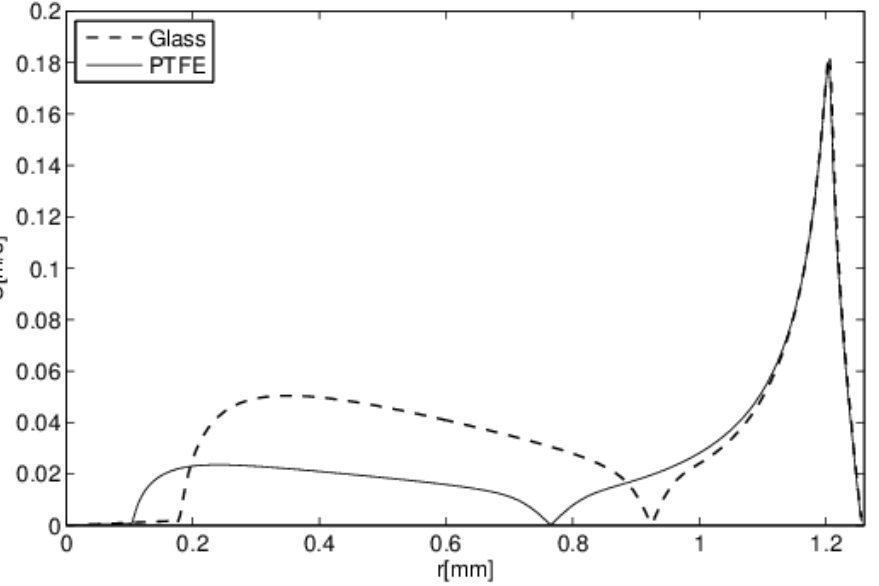
Figure 14. TBH configuration: velocity evolution along the interface. Influence of the substrate nature (t = 1 s, θ = 90 ◦ , V 0 = 1 mm 3 , T h = 50 ◦ C, Φ = 3 mW).